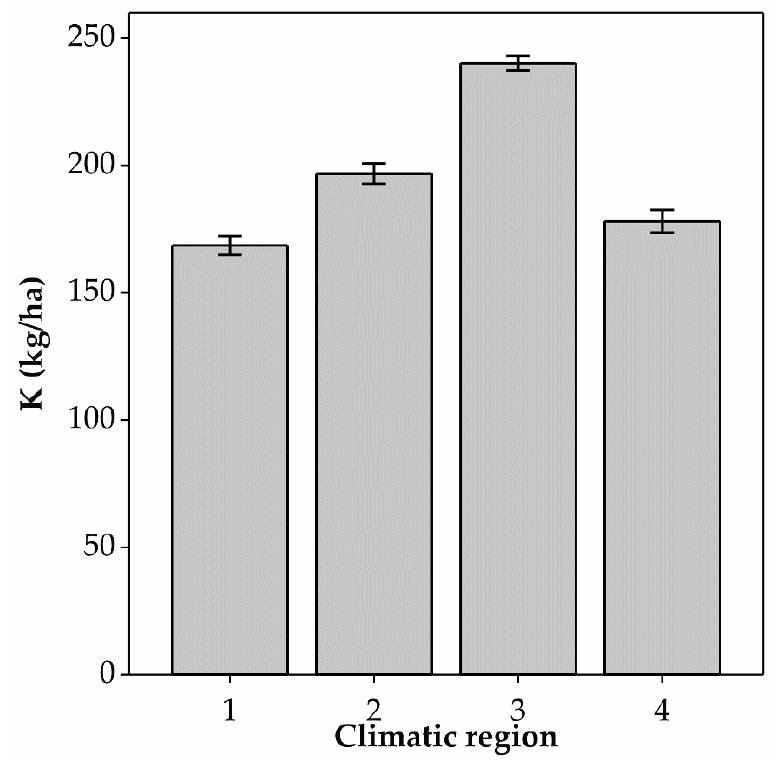
Figure 2. Mean values ( n = 144) for K loading in two cropping systems of the four different climatic regions (1; Climatic region 1, 2; Climatic region 2, 3; Climatic region 3 and 4; Climatic region 4) of South Africa.